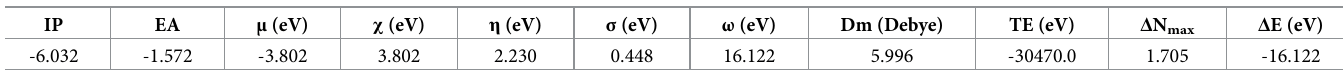
Table 2. The calculated global reactivity indices and energetic parameters for T-1-MTA.